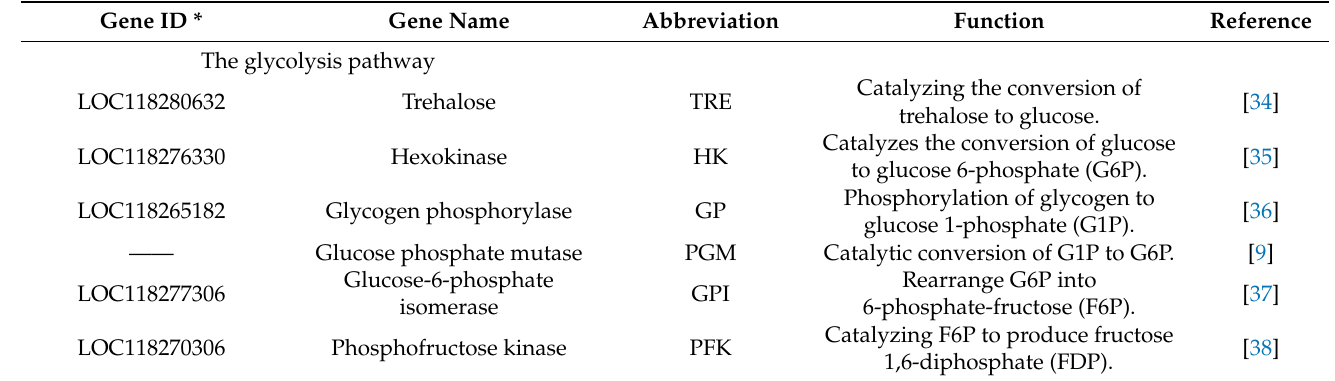
Table 1. Enzymes and metabolites (full name and abbreviations) of flight energy metabolism